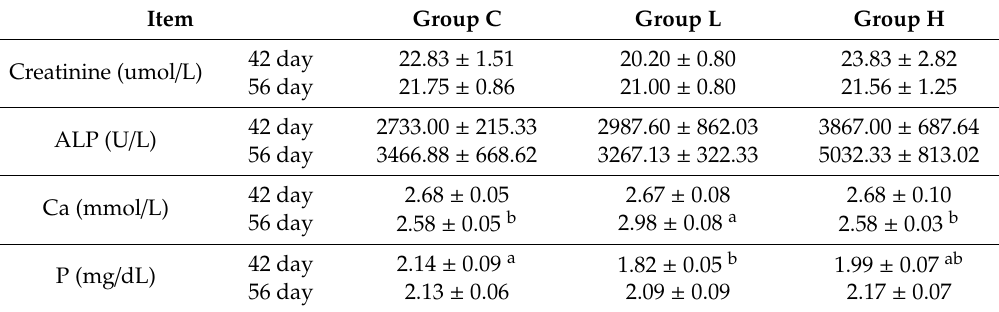
Table 4. The changes of serum biochemical indicators in broilers.